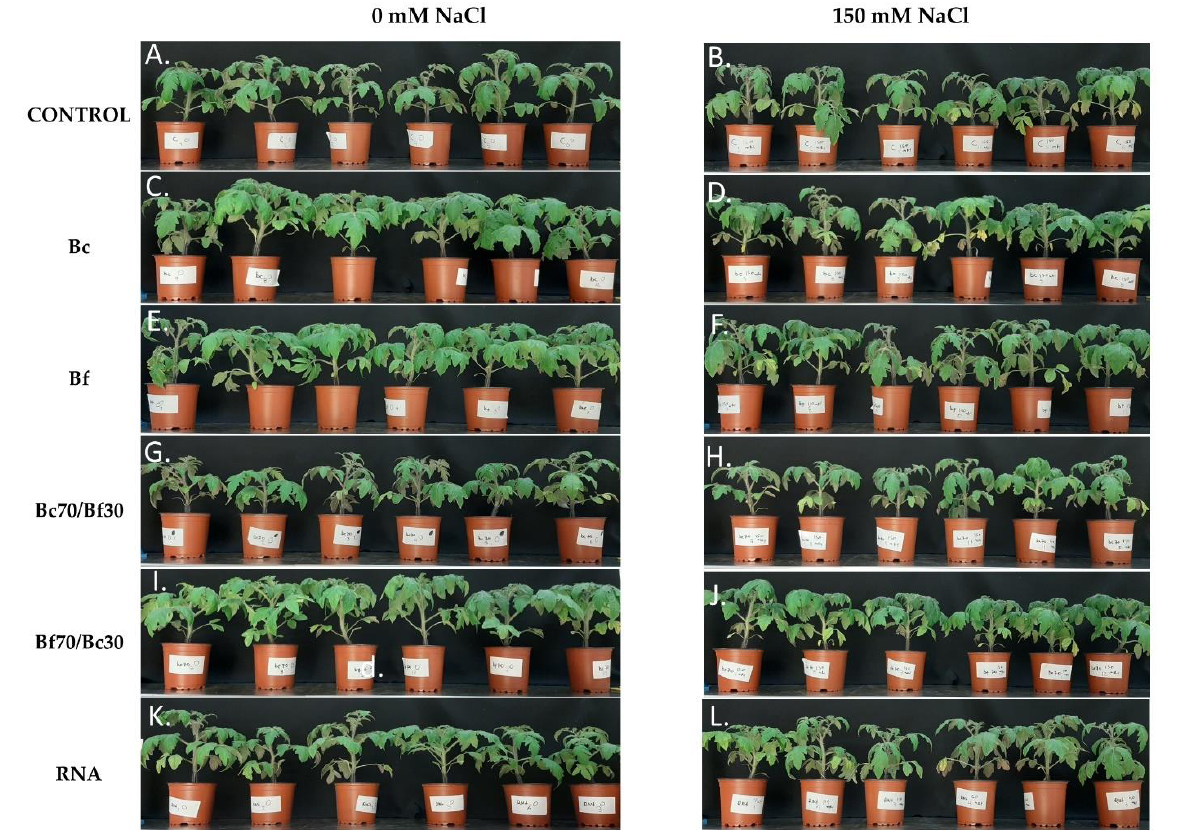
Figure 1. Phenotypic effects of biostimulant application on tomato plants grown in the absence (0 mM NaCl) and presence (150 mM NaCl) of salinity stress with respective controls. ( A ) Control, non- treated and not-stressed, ( B ) Non biostimulant-treated and 150 mM NaCl stressed, ( C ) biocompost (Bc) biostimulant-treated, not stressed, ( D ) biocompost (Bc) biostimulant-treated, 150 mM NaCl stressed, ( E ) biofertilizer (Bf) biostimulant-treated, not stressed, ( F ) biofertilizer (Bf) biostimulant- treated, 150 mM NaCl stressed, ( G ) biocompost 70%/biofertilizer 30% (Bc70/Bf30) biostimulant- treated, not stressed, ( H ) biocompost 70%/biofertilizer 30% (Bc70/Bf30) biostimulant-treated, 150 mM NaCl stressed, ( I ) biofertilizer 70%/biocompost 30% (Bf70/Bc30) biostimulant-treated, not stressed, ( J ) biofertilizer 70%/biocompost 30% (Bf70/Bc30) biostimulant-treated, 150 mM NaCl stressed, ( K ) RNA corrector (RNA) biostimulant-treated, not stressed, ( L ) RNA corrector (RNA) biostimulant- treated, 150 mM NaCl